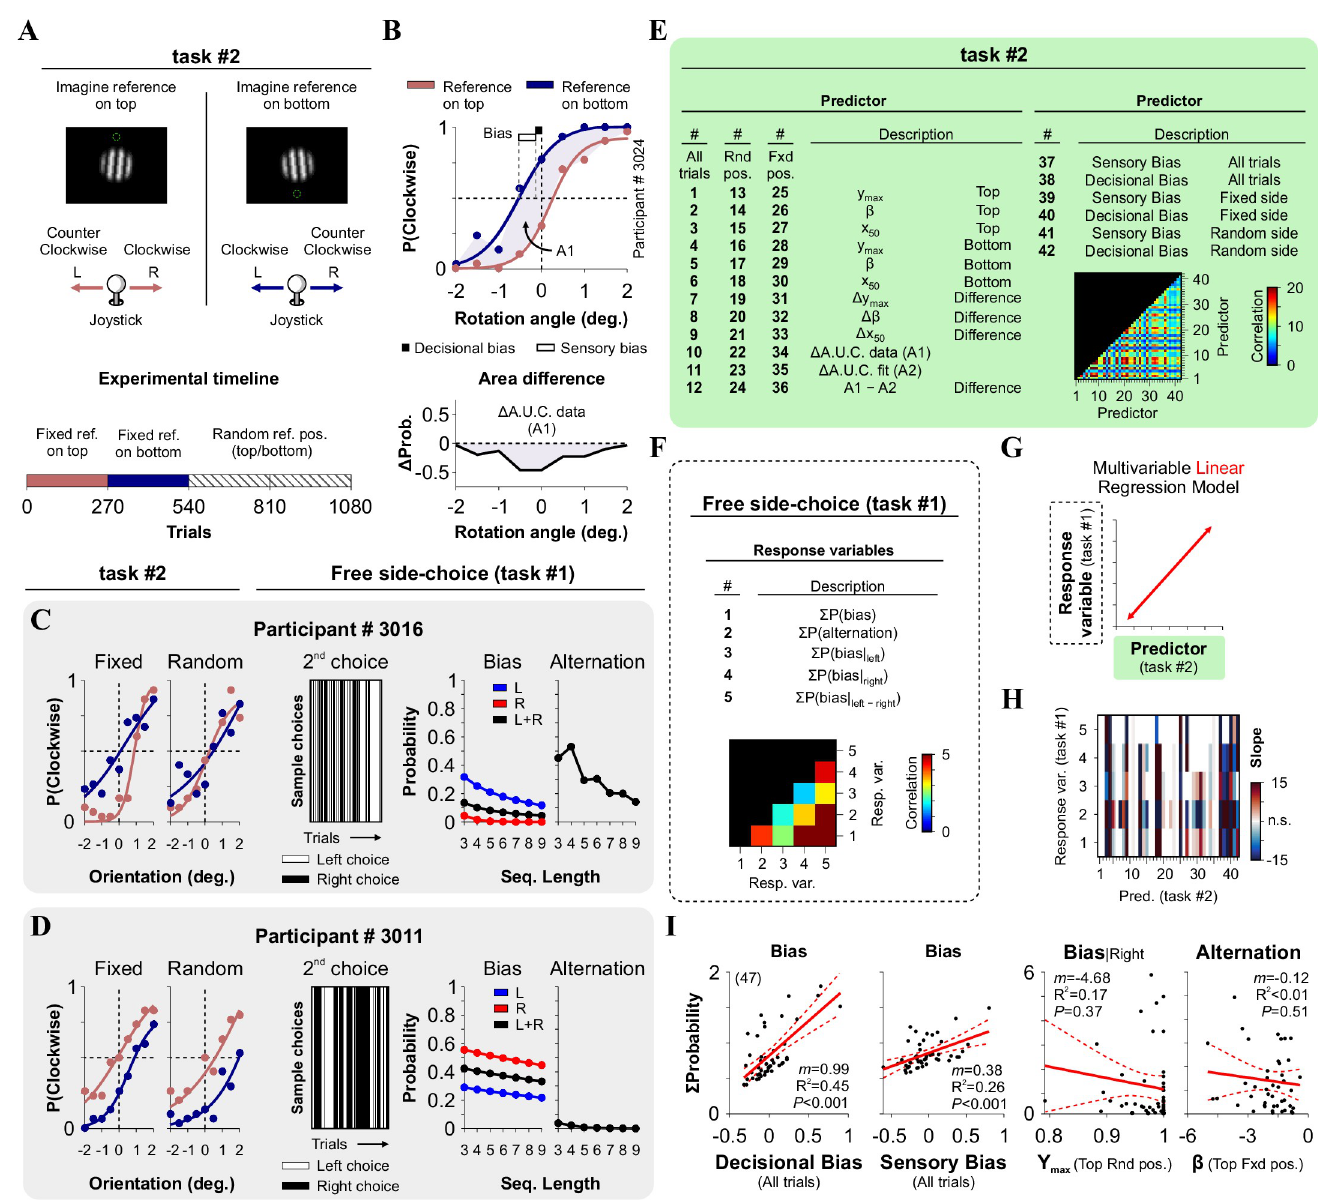
Fig 2. Comparison of choice-biases measured with two perceptual tasks. (A) Representation of Lo´pez-Moliner’s task (task #2), which allows the dissection of sensory and decisional biases [7]. The diagram shows two trials in which the participants had to imagine a reference either on top (panel on the left) or on the bottom of the screen (panel on the right). (B) Example of an average choice response curves and psychometric curves from trials with top (indian red) and bottom (federal blue) references. Decisional (black square) and sensory (empty rectangle) biases can be extracted from each participant’s psychometric fits. (C-D) Two examples of experimental results from participants #3016 and #3011 solving task #2 (left panels) and our free side-choice task (center and right panels). (E) List of the 42 predictors extracted from task #2. y max (asymptote), β (steepness) and x 50 (inflection point) correspond to the parameter fits from the psychometric curves. Δ A.U.C. (A1) is the area under the curve for the differences in choice responses with the reference on top and bottom (lower panel in B), and Δ A.U.C. (A2) corresponds to the differences from the psychometric fits obtained with the reference on top and bottom. (F) List of 5 response variables from the free side-choice task (task 1). Insets in panels E and F show the cross-correlation coefficients across predictors and response variables. Using PCA: the first 15 principal components explained 99.5% of the variance of the 42 predictors, whereas the first two principal components explained 90.74% of the variance of the 5 response variables. (G) Observed slopes from the MLRM comparing how parameters extracted from task #2 (rows) predicted measures from our free side-choice task (columns, task #1). Non-significant interactions appear as empty rectangles. (H) Sample linear regressions using relevant pairs of predictors/responses. Number of subjects in